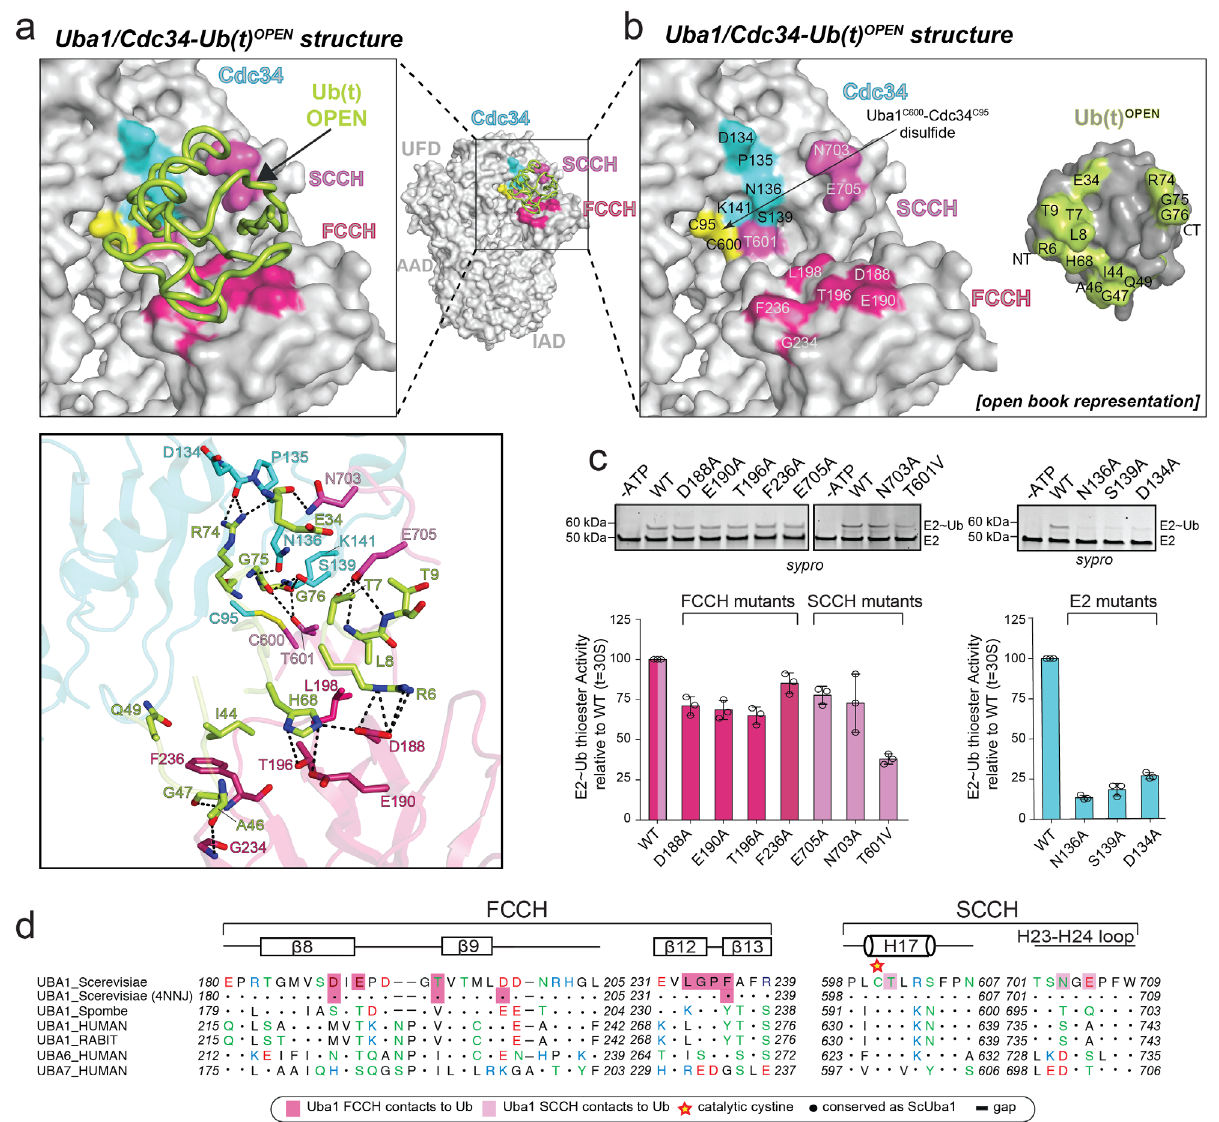
Fig. 3 Interfaces of Uba1/Cdc34 A141K – Ub(t) OPEN structure. a Top, Uba1/Cdc34 A141K -Ub(t) OPEN structure with surfaces of Uba1 domains and Cdc34 gray with only contacting residues colored. Ub(t) is represented as loop and colored limon. Bottom, Network of contacts between Uba1, Cdc34, and Ub(t) with involved residues shown as sticks with red oxygen atoms, blue nitrogen atoms, and yellow sulfur atoms. Hydrogen bonds are indicated by dashed lines. b Surface representations of Uba1, Cdc34, and Ub(t) shown in open book representation with residues in the interface colored hot pink (FCCH domain), light magenta (SCCH domain), cyan (E2), and limon (Ub(t)). c E1 – E2 thioester transfer assays of the indicated mutants for Uba1 FCCH and SCCH domains. Data are represented by mean ± SD with three independent technical replicates labeled above and individual replicates shown as black circles. Gel images are representative of independent technical replicates ( n = 3). Source data are provided as a Source Data fi le. d Sequence alignment of Uba1s FCCH and SCCH across different species with Uba1 ’ s secondary structure cartoon shown above sequence. Shaded boxes indicate Uba1 residues that interact with the